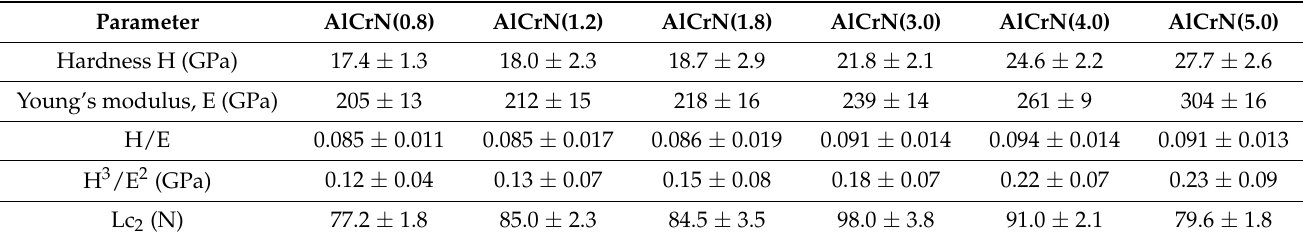
Table 1. Mechanical properties of AlCrN coatings formed at various pressure of nitrogen.